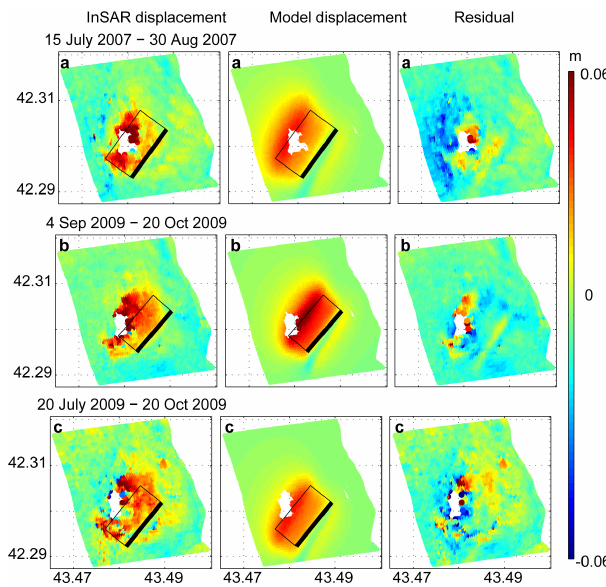
Fig. 8. Observed quantities (left), modelled quantities (middle) and the residual (right). The mining activity was not accounted for in the modelling. The parameters of the model are given in Table